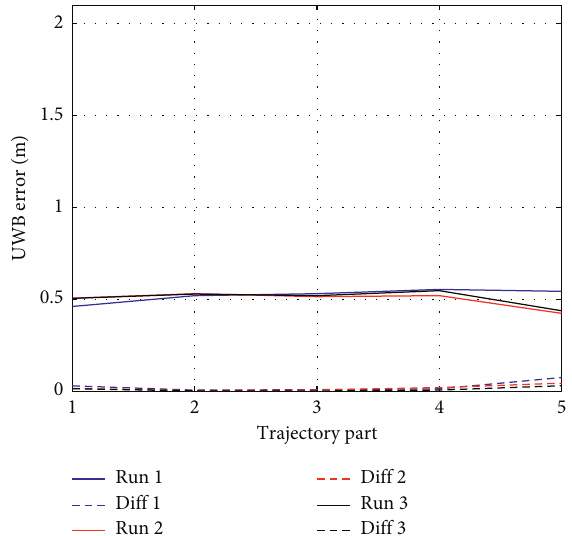
Figure 17: The difference between the UWB and RTK-SN posi- tions for three reruns of the experiment shown in Figure 16. The dotted lines show the difference from each individual test to the average, indicating the repeatability.